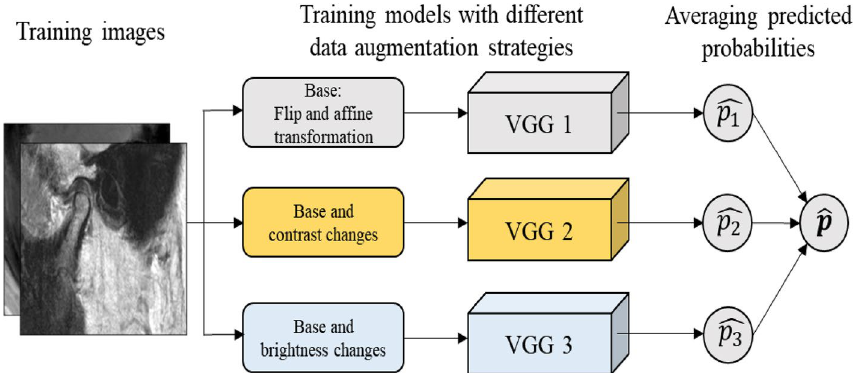
Figure 3. Architecture of the convolutional neural network (CNN) ensemble model. Three VGG16 models are learned using different data augmentation techniques. Base: randomly flip vertical and affine transform image. Contrast changes: randomly changed contrast values and applied histogram equalizations. Brightness changes: randomly changed image brightness. CNN, convolutional neural